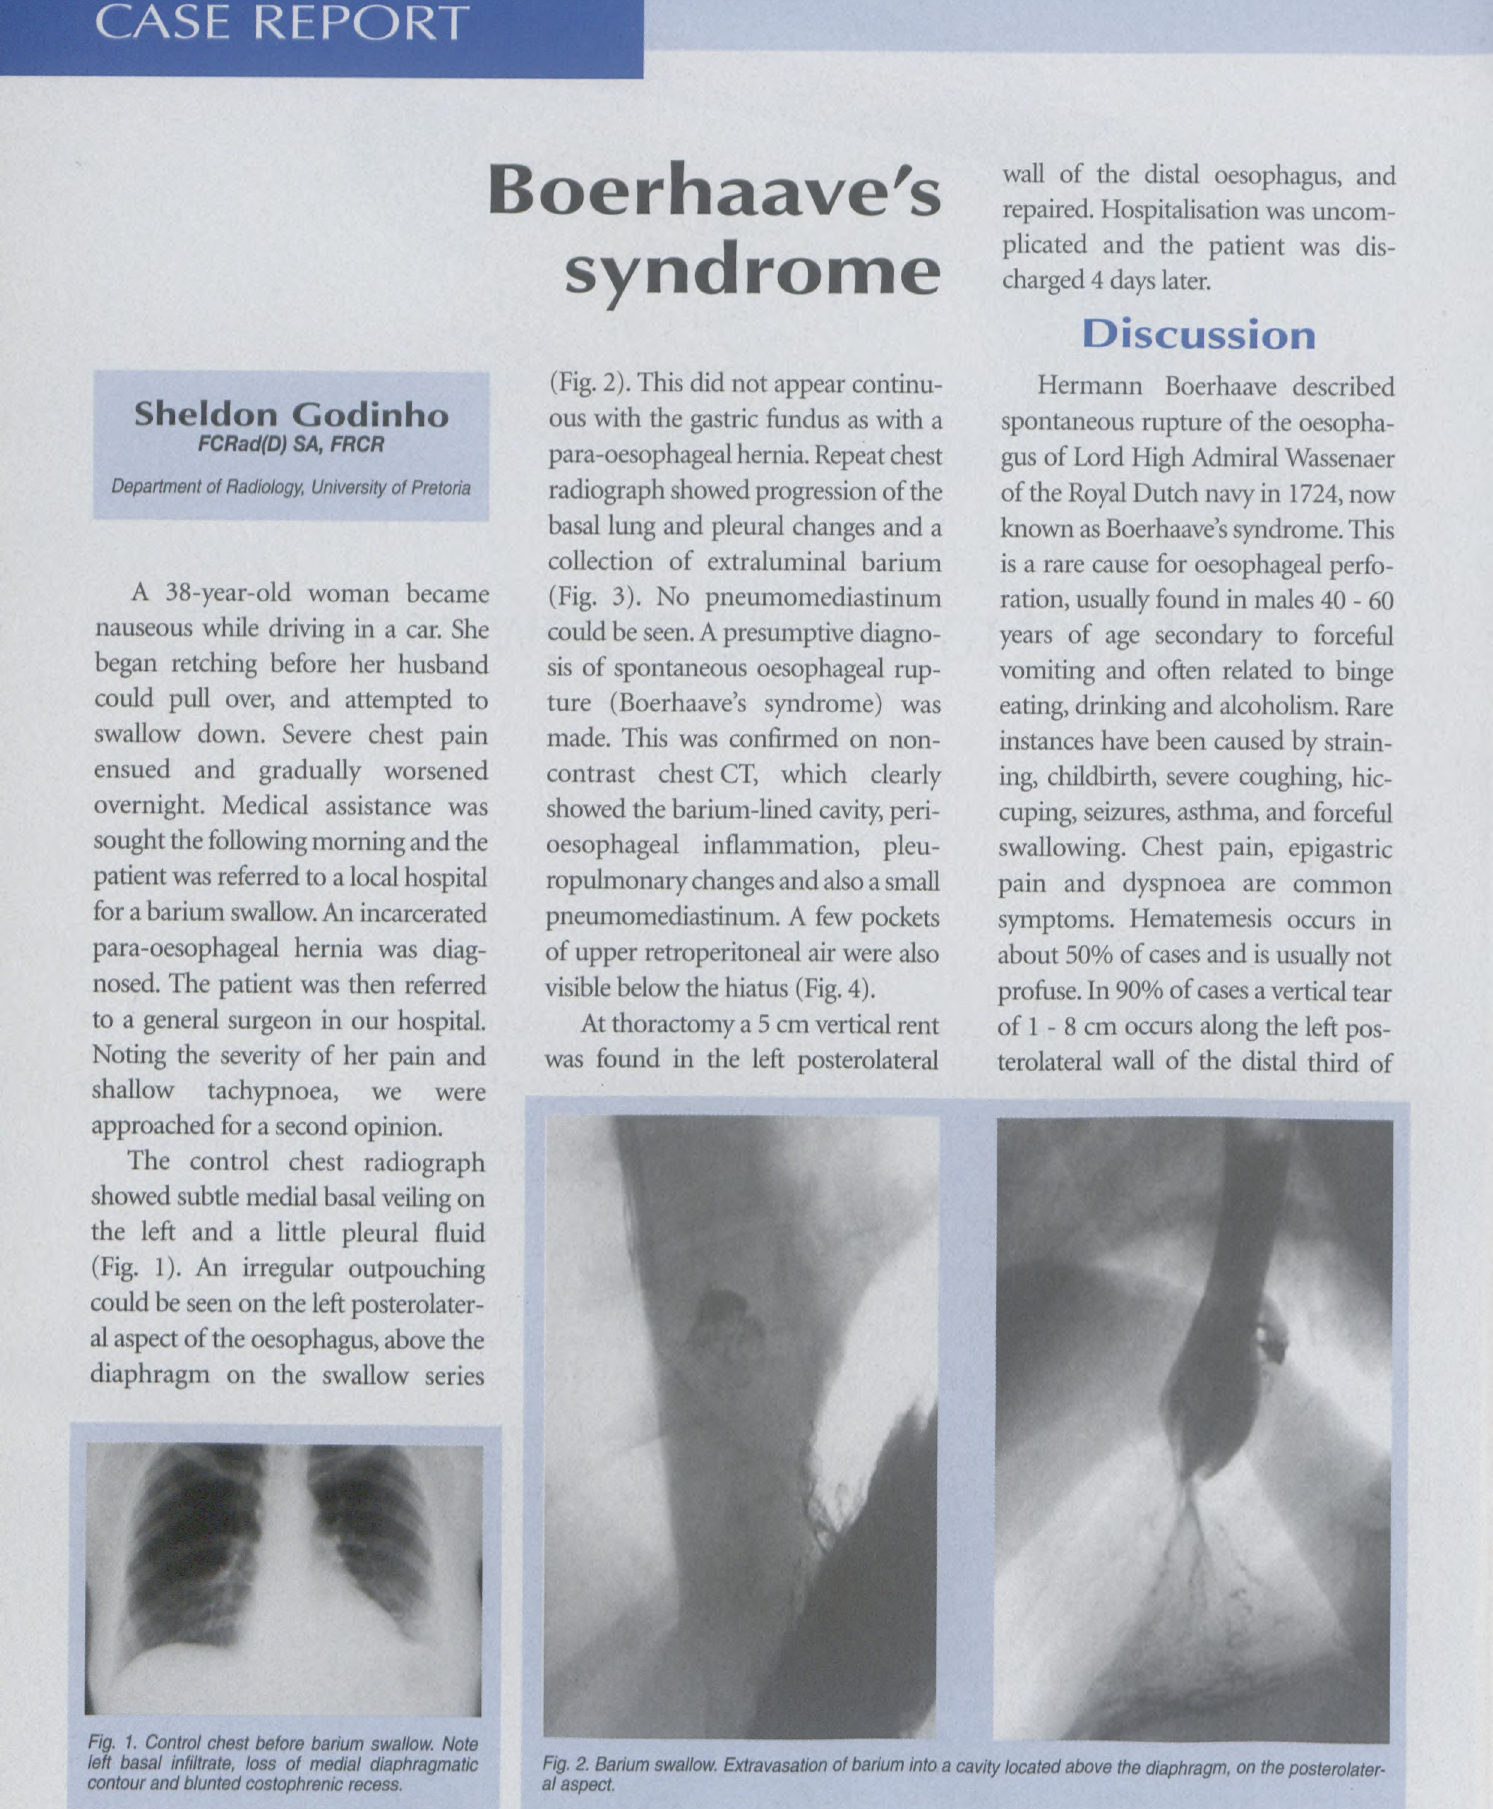
Fig. 1. Control chest before barium swallow. Note left basal infiltrate, loss of medial diaphragmatic contour and blunted costophrenic recess.